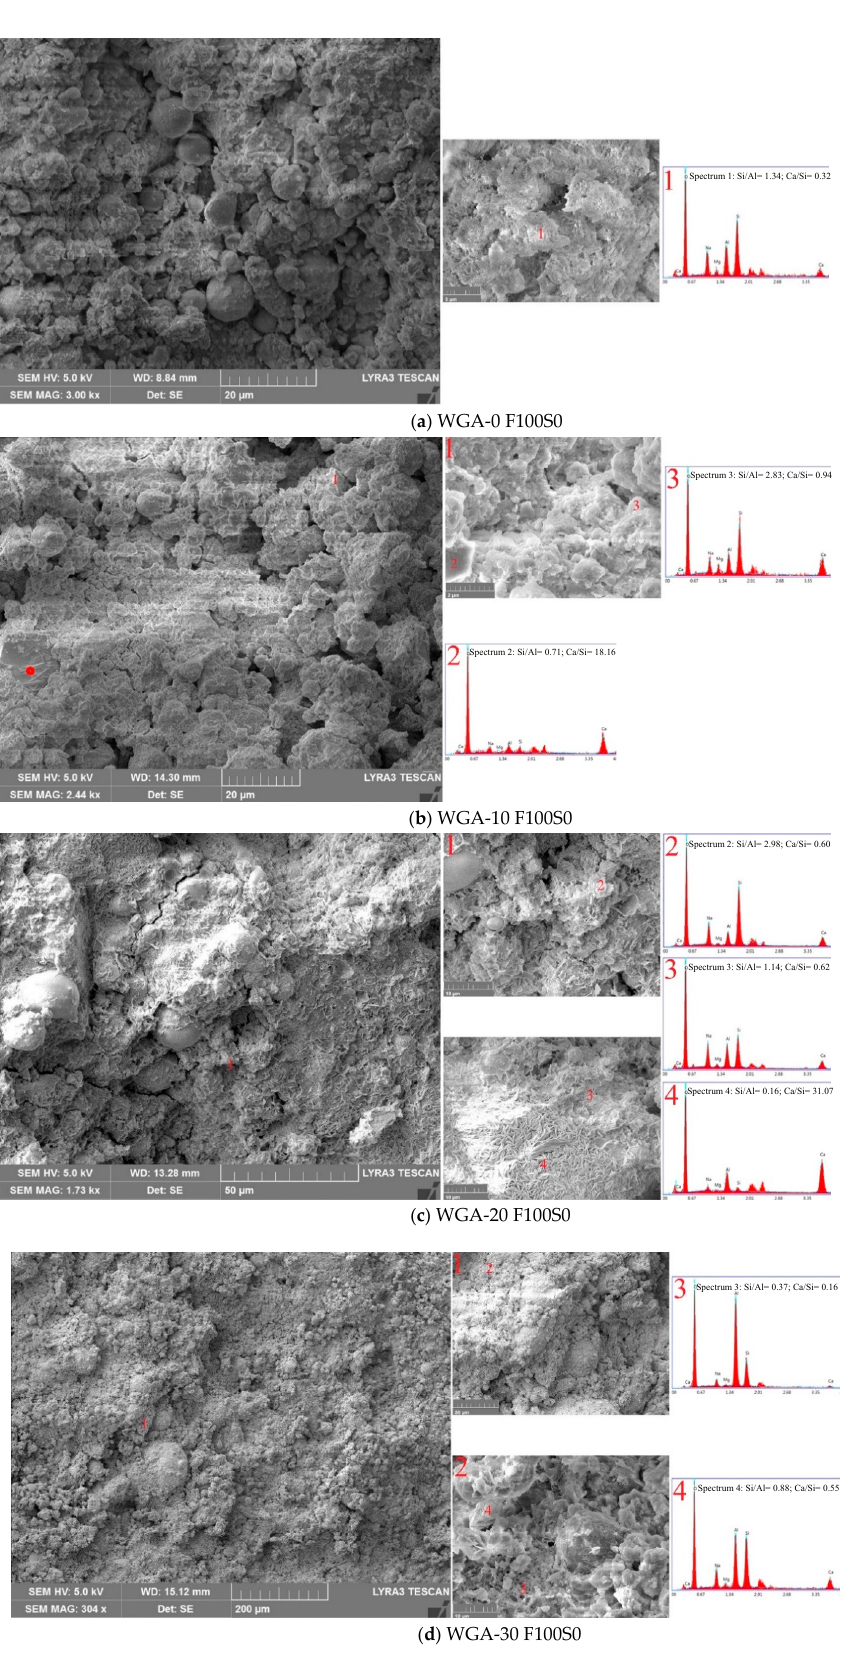
Figure 11. SEM Micrographs and EDX spectra of sample F100S0 activated in ( a ) WGA-0, ( b ) WGA-10, ( c ) WGA-20 and ( d ) WGA-30 solution.